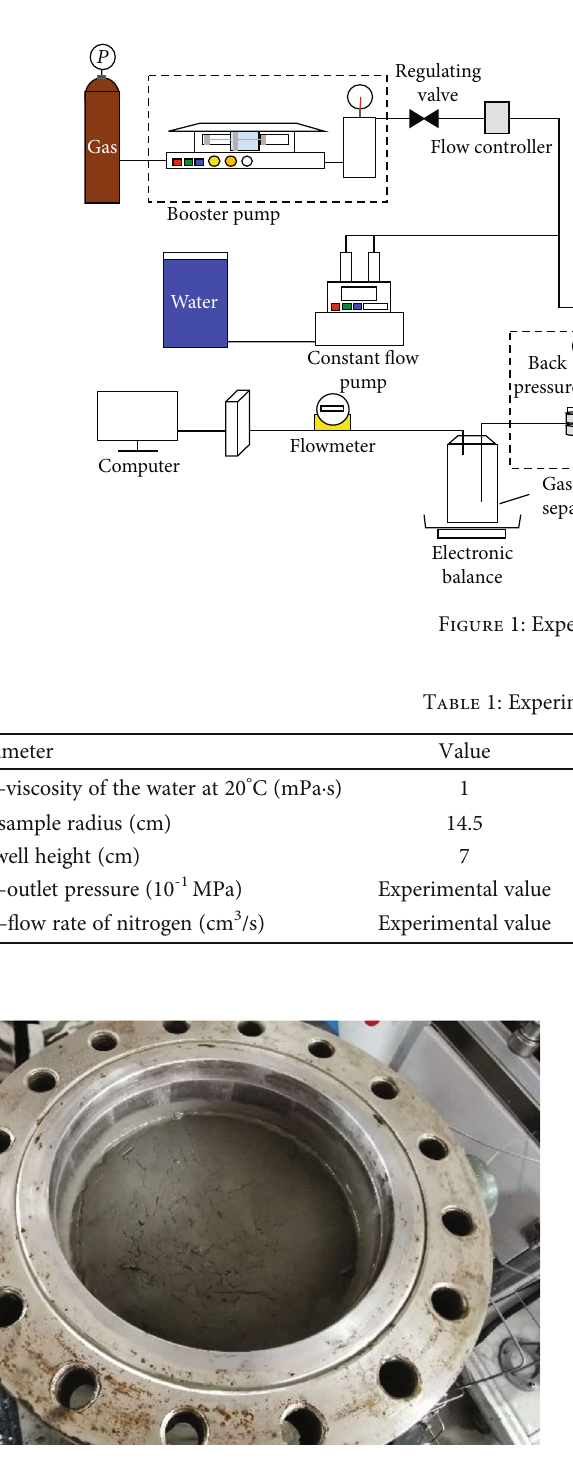
Figure 2: Compacted